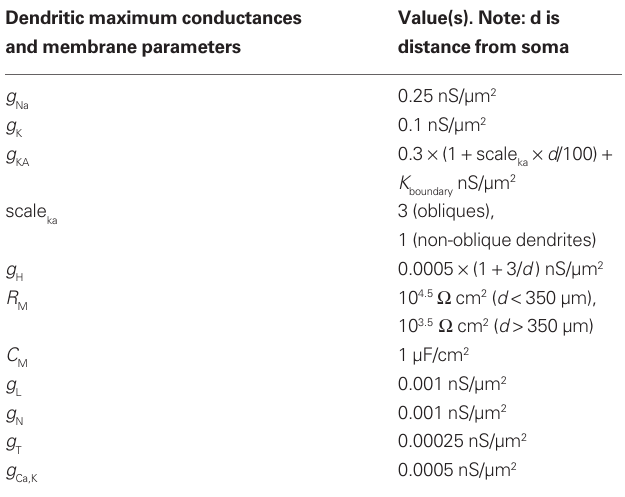
Table 1 | The basic membrane properties in the model. The set of constants, K , are 0 on the apical trunk, and adjusted in the obliques so boundary that g (d) is “continuous” from the trunk onto each oblique. The last four A conductances were only present in simulations that examined calcium effects. The axon (no I ) and soma ( I with different kinetics in soma and A A proximal dendrites) have other simple distributions. See model code in ModelDB for details. We recommend NEURON’s ModelView tool for viewing the spatial distributions of these and other parameters (Hines et al.,